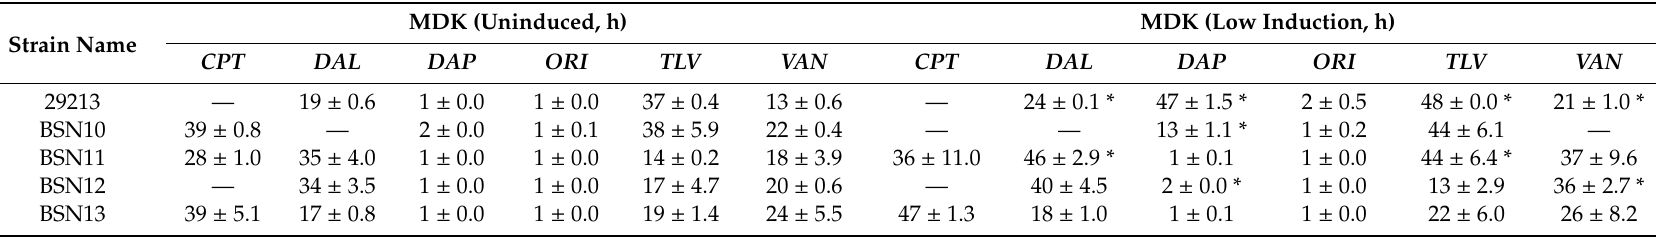
Table 1. Time to bactericidal activity under low induction conditions. Under low mupirocin exposure, MDK is prolonged in an isolate- and antibiotic-dependent manner. Dashed line (—), MDK not achieved over 48 h; *, p < 0.05.